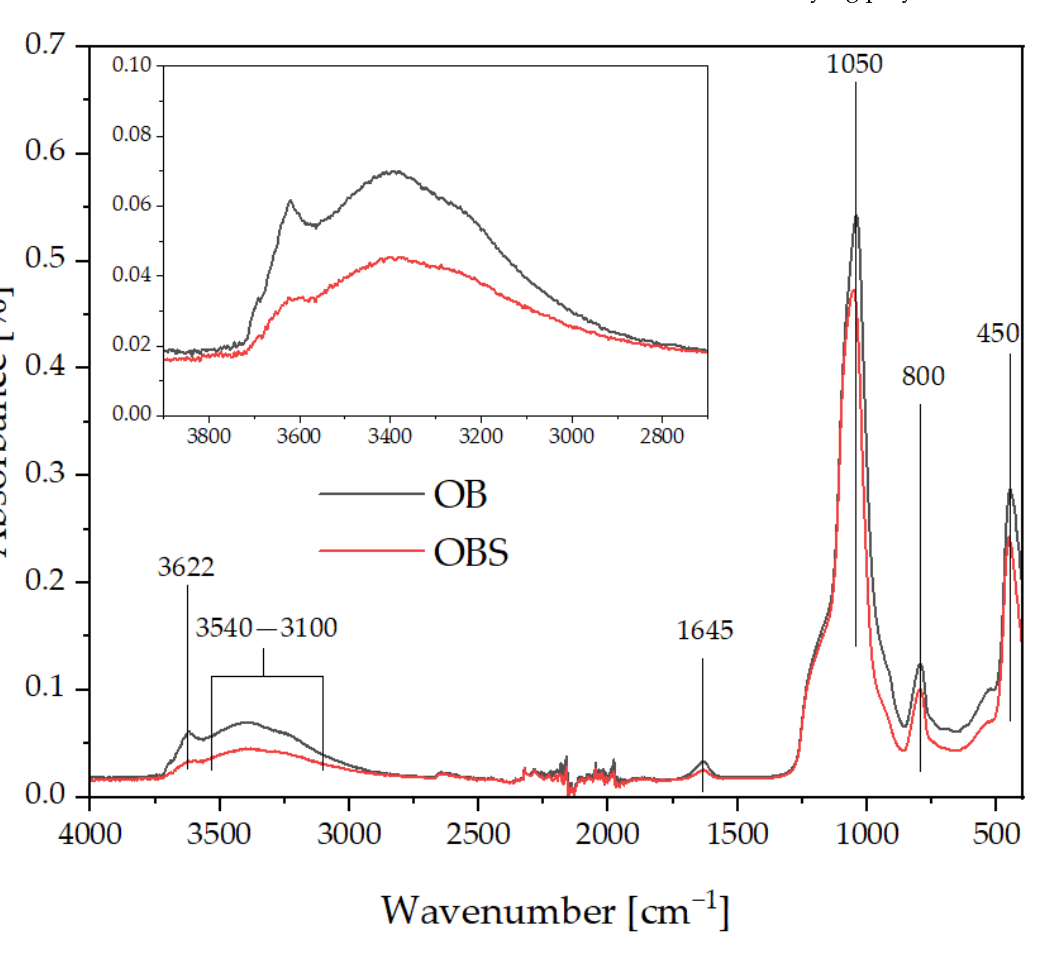
Figure 3. FT-IR spectra of neat, base diatomaceous earth (OB) and silanized diatomaceous earth